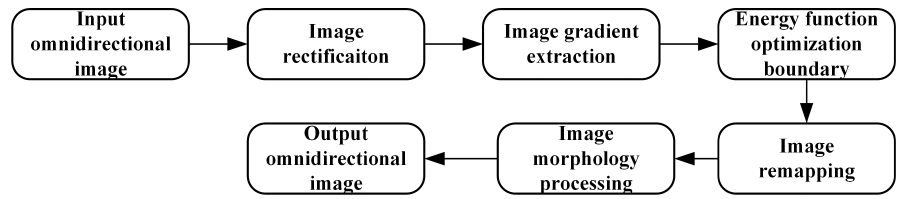
Figure 3. Flowchart of the method of sky region